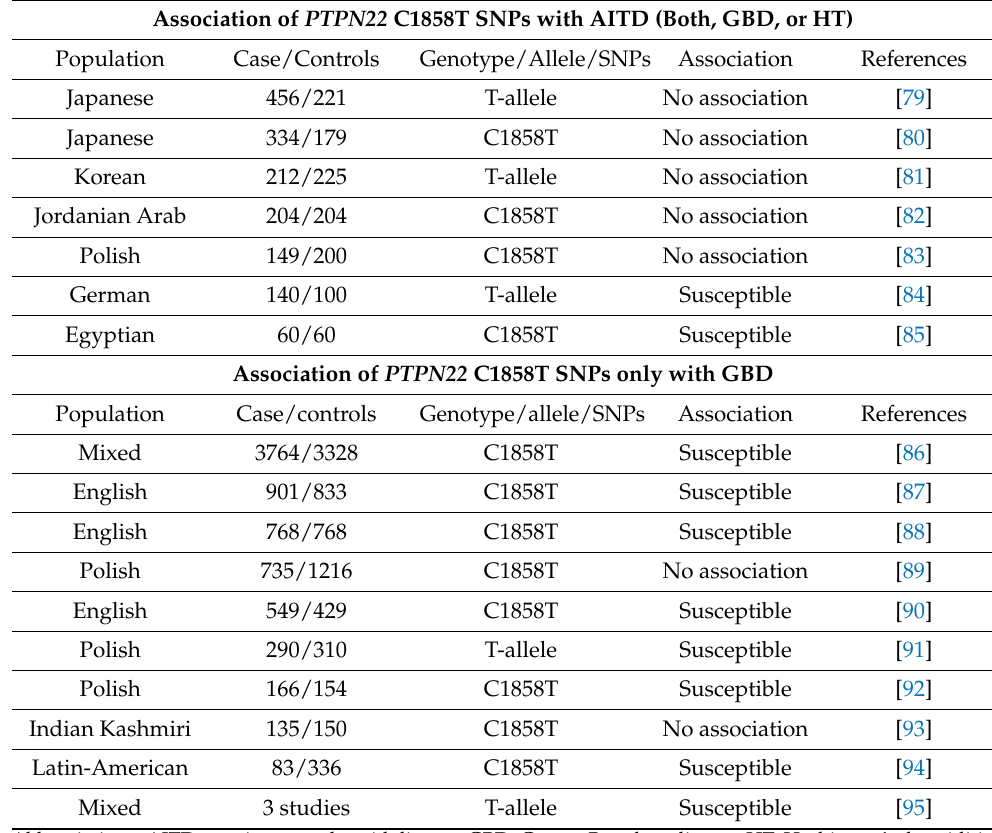
Table 3. Association of PTPN22 C1858T SNPs with AITD